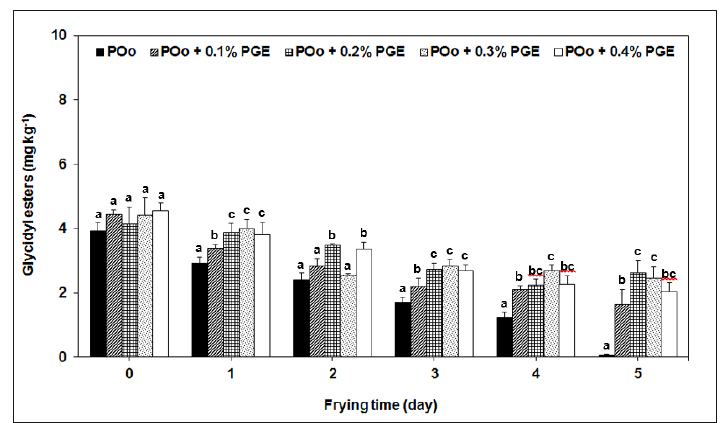
Figure 2. Reduction of glycidyl esters in POo added with PGE during repeated frying. One-way analysis of variance (ANOVA) was used to indicate the significant difference between the control experiment (POo without PGE) and each frying interval ( p < 0.05) as showed by different lowercase letters.